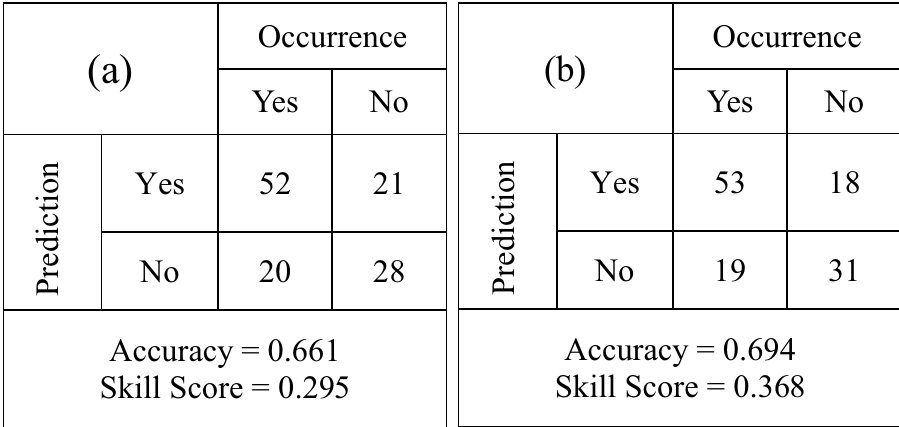
Table 2 Contingency table for the 24–48 h categorical forecast of Es layer